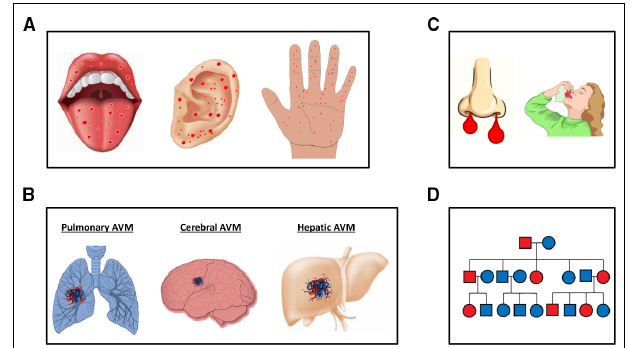
FIGURE 1 | Curaçao clinical criteria in HHT. (A) Multiple telangiectases at characteristic sites, such as oral cavity, ears, and fingers. (B) Visceral lesions (AVMs) in the lungs, brain, liver or spinal cord, and gastrointestinal bleeding. (C) Epistaxis (spontaneous, recurrent nosebleeds). (D) An example of a family history of HHT; a genetic family tree with affected members in red and non-affected members in blue is